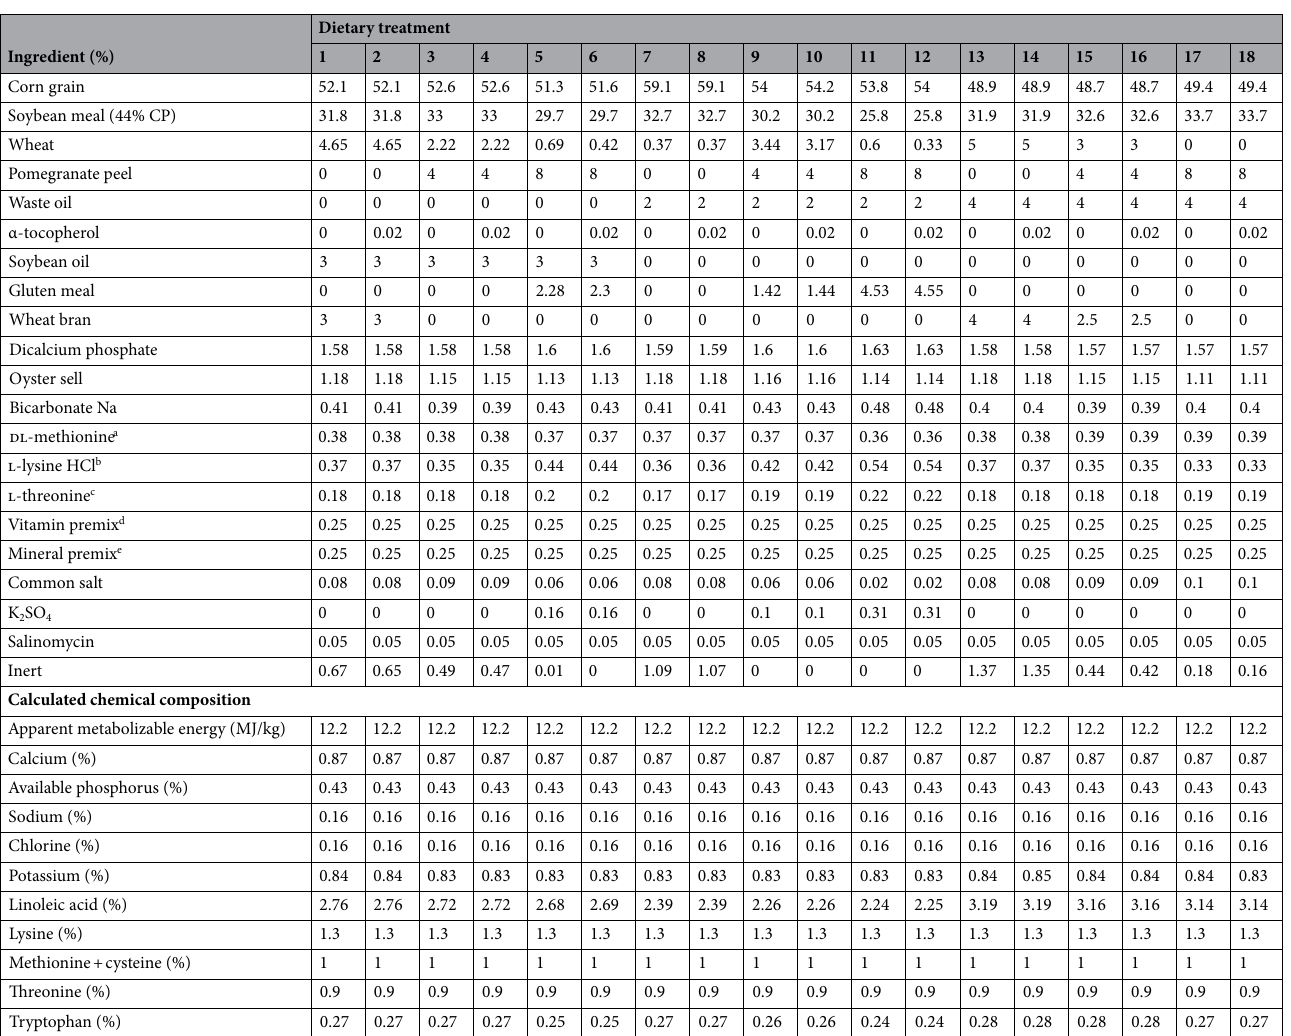
Table 1. Ingredient composition and calculated chemical composition of the diets (11–24 days). a dl- methionine, feed grade 99% (Evonik methionine), b l-lysine feed grade 98.5% (Alborz Gostar Darou Co), c l- threonine, feed grade 98.5% (Evonik methionine). d Vitamin mixture provided per kilogram of diet: 15,000 IU vitamin A (retinol), 3750 IU vitamin D3 (cholecalciferol), 20.20 mg vitamin E (α-tocopherol), 3.7 mg vitamin K3 (menadione), 3 mg vitamin B1 (thiamine), 7.5 mg of vitamin B2 (riboflavin), 55 mg vitamin B3 (niacin), 4.5 mg of vitamin B6 (pyridoxine), 1 mg vitamin B7 (biotin), 15 mg vitamin B12 (cobalamin), and 11.5 mg of vitamin B5 (pantothenic acid). e Mineral mixture provided per kilogram of diet: 50 mg Mn (manganese), 47 mg Zn (zinc oxide), 25 mg Fe (iron), 7.5 mg Cu (copper sulfate), 2.6 mg I (iodine), and 0.40 mg Se